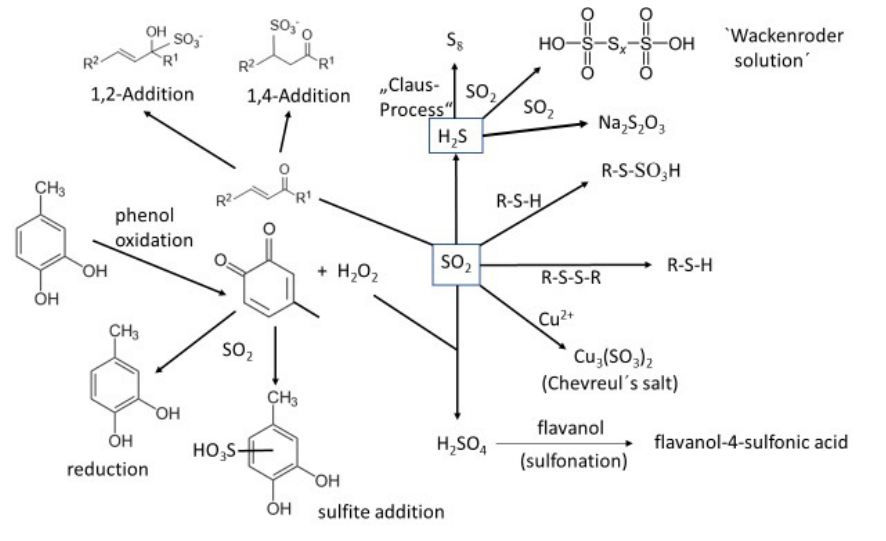
Figure 4. Reactions of SO 2 with wine components (top right: the formation of polythionates from the yeast metabolites H 2 S and SO 2 ).